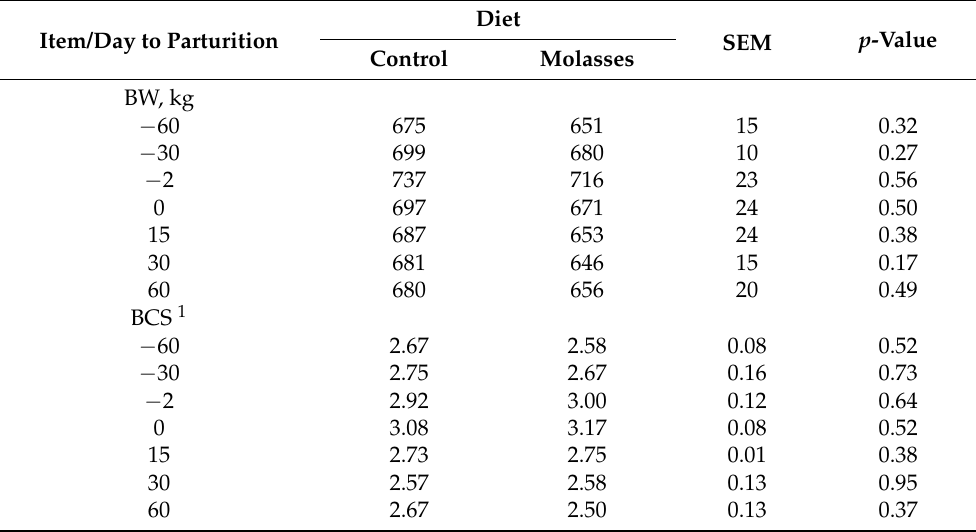
Table 8. Prepartum and postpartum Body weight (BW) and BCS (Body Condition Score) of cows fed control or molasses-containing diets during a 60 day dry period (Experiment 2).